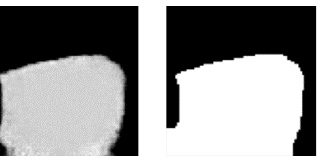
Figure 5. Examples for a segmentation map ˆ s ( left ) and the processed binary segmentation map ˆ s b ( right ).